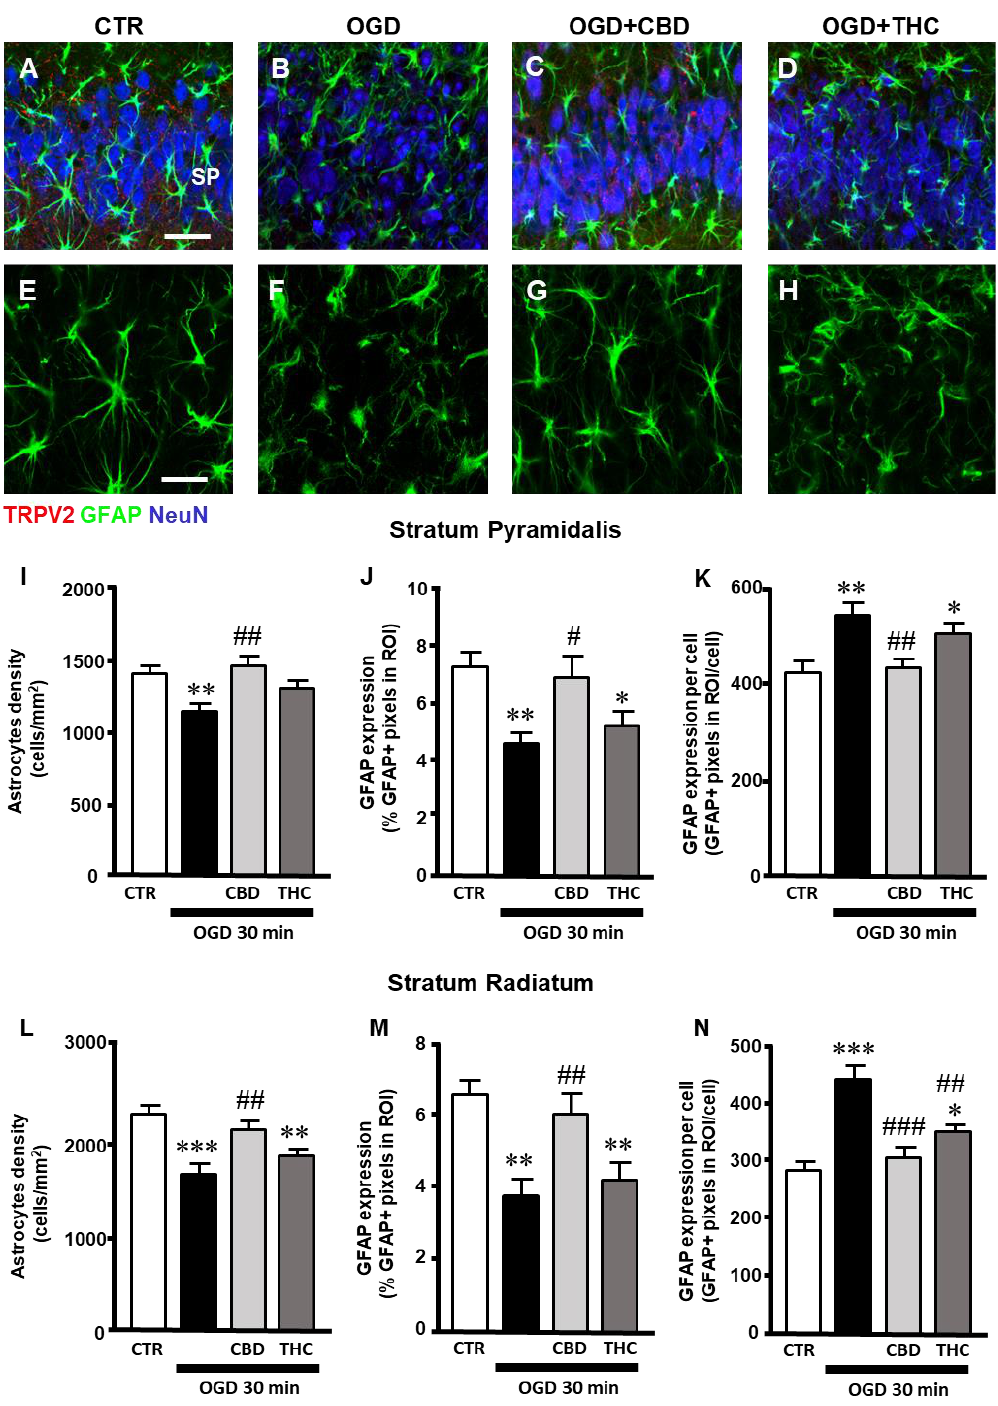
Figure 2. ( A – D ) Representative confocal images of immunostaining of TRPV2 channels (TRPV2, red), astrocytes (GFAP, green), and neurons (NeuN, blue) in CA1 SP and SR of CTR ( A ), OGD ( B ), OGD + CBD ( C ), and OGD + THC ( D ) slices. Images are z-projections of 10 confocal z-scans captured with a 40× objective (total thickness: 6 µm). Scale bar: 40 µm. ( A – D ) No colocalization of TRPV2 channel with astrocytes is present in the four experimental groups. ( E – H ) Enlargements of confocal images in panels ( A – D ) of astrocytes ’ immunostaining (GFAP, green). In OGD slices ( F ), astrocytes changed their morphology, becoming clasmatodendrotic, with shorter, thicker, and twisted branches compared to astrocytes from control slices ( E ). Treatment with CBD prevented the clasmatodendrotic modifications of astrocytes ( G ), while THC had no significant effect ( H ). ( I ) Quantitative analyses of astrocytes ’ density in CA1 SP of CTR (n = 11), OGD (n = 11), OGD + CBD (n = 12), and